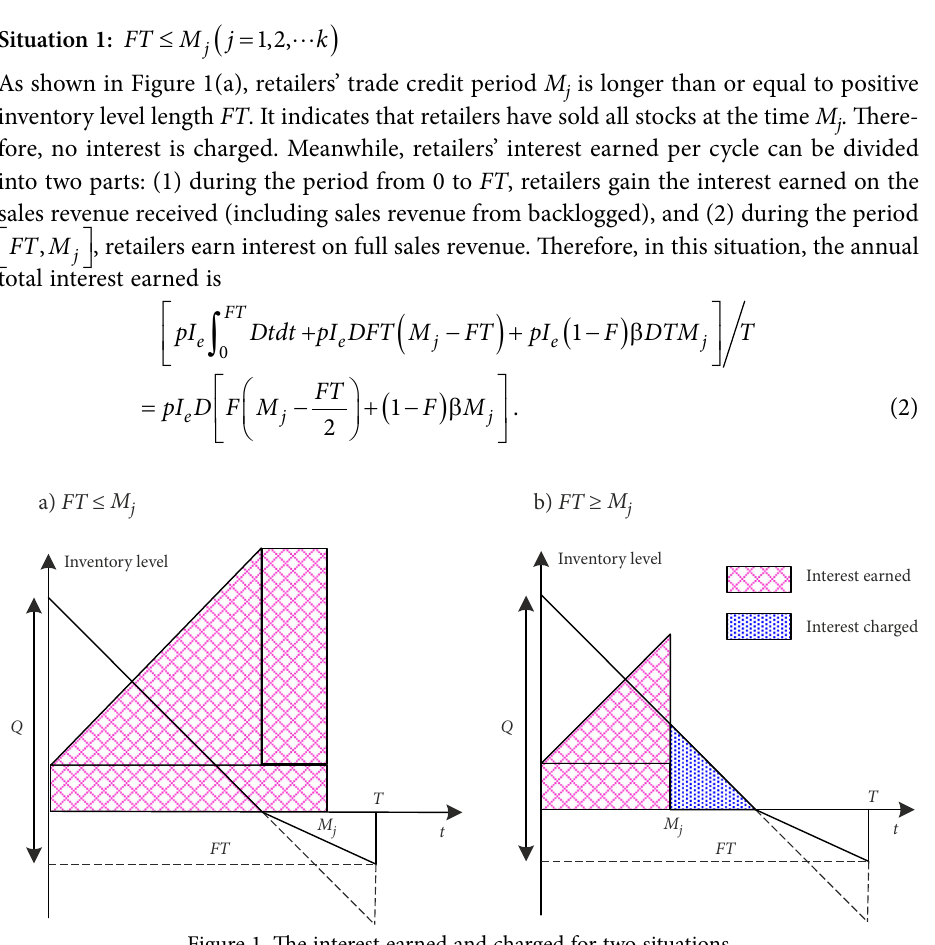
Figure 1. The interest earned and charged for two